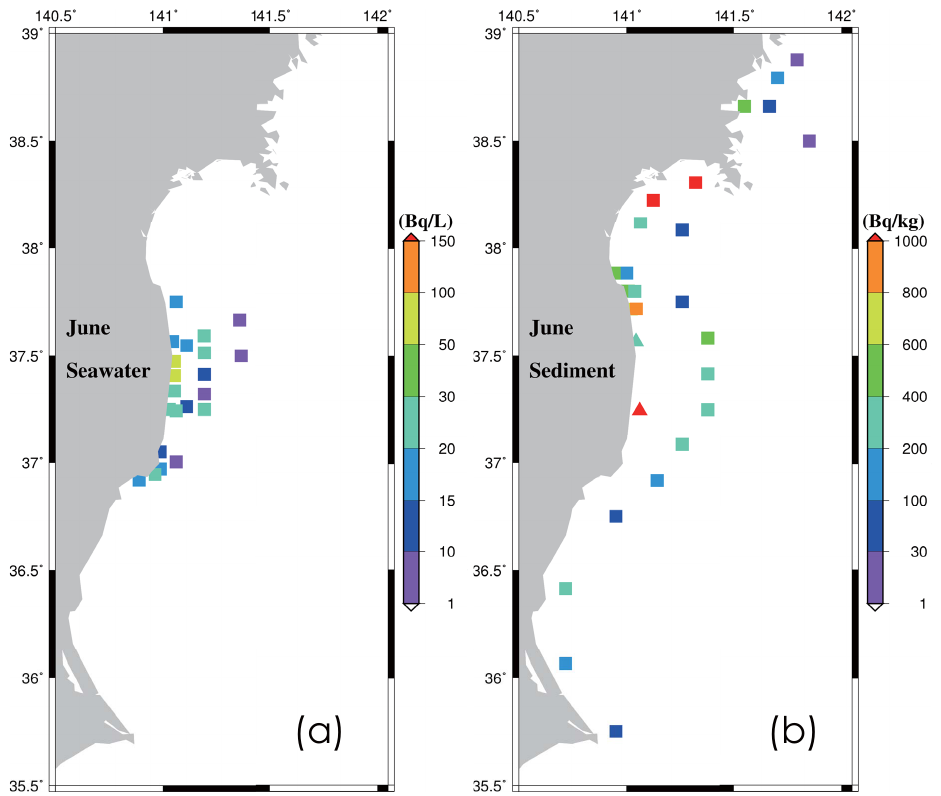
Fig. 2. Concentrations of radionuclides in (a) seawater [BqL − 1 ] and (b) bottom sediments [Bqkg − 1 dry] observed in June, 2011 (MEXT, 2011). Samplings of seawater were taken from surface to 150m depth. Note that data from TEPCO are measured in [Bqkg − 1 wet] and are shown in triangles. The values are also converted to [Bqkg − 1 dry] by multiplying by 0.75 (MEXT, 2011). Higher levels of radionuclides are observed near the FNPP and also along the coast from the southern tip of Ibaraki to the Sendai